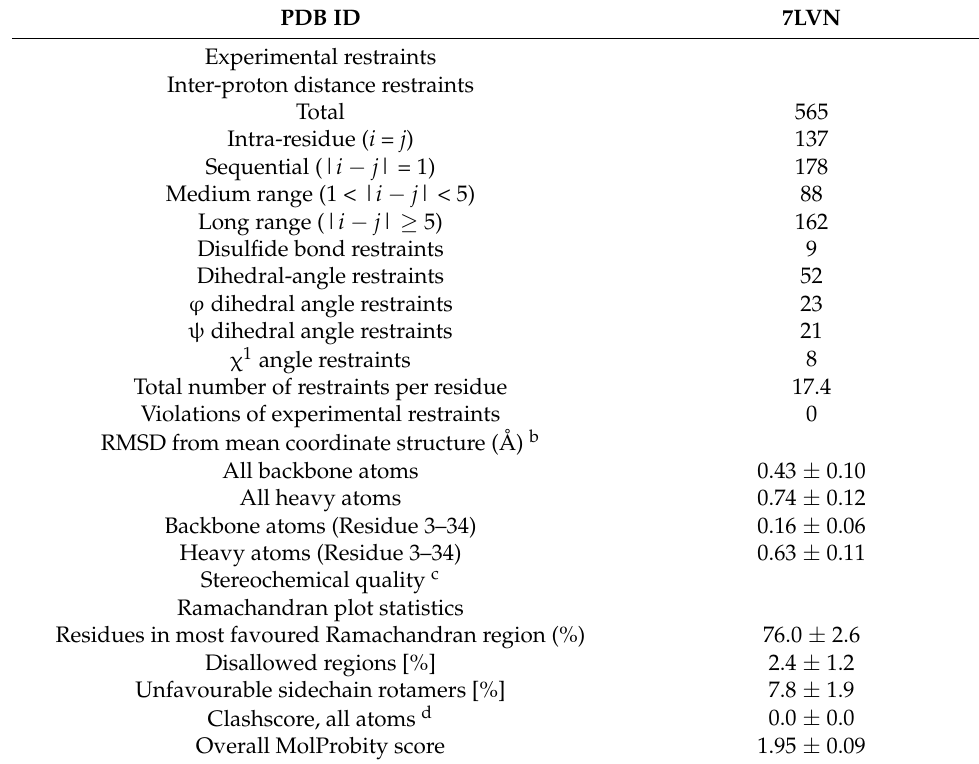
Table 1. Structural statistics for the NMR ensemble of ω -Avsp1a a